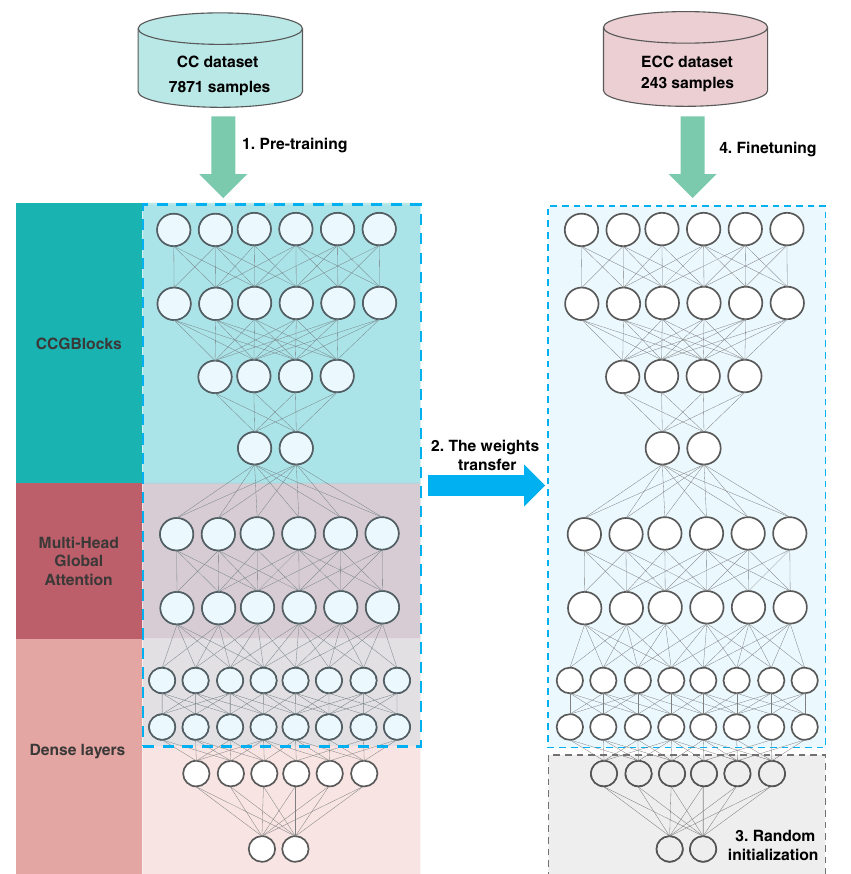
Fig. 5 The fl ow chart of the transfer learning for the energetic co-crystals. The energetic cocrystal prediction model is also based on the CCGNet framework involving CCGBlocks, Multi-head Global attention and dense layers. The CC dataset is fi rst applied to pretrain the model. Then the weights pretrained on CC dataset are served as initialization weights of CCGBlocks, Multi-Head Global Attention and part of dense layers (boxes surrounded by blue dotted-lines), which is called as weight transfer. Then, the last two dense layers are initialized randomly (Gray box). Finally, ECC dataset is used to fi netune all the weights of the